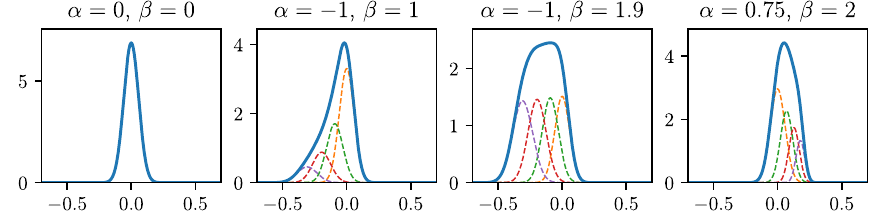
Figure 3. Example distributions of the constrained mixture density output. All subplots use location ξ = 0 and scale ω = 6 × 10 − 2 , but varying skewness α and shape β . The plots show the resulting mixture distributions (solid) and the four underlying Gaussian components